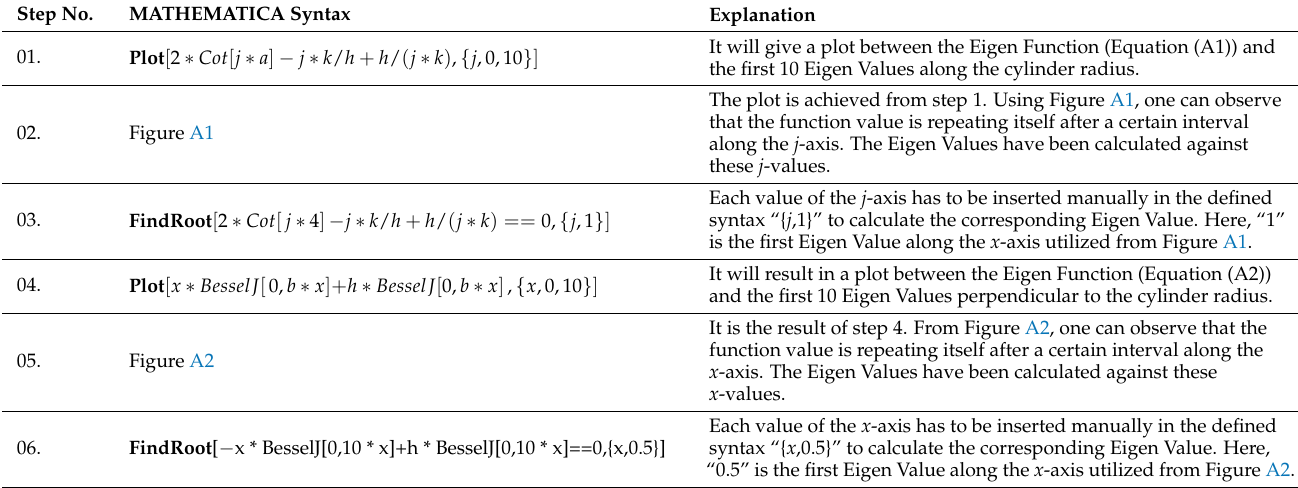
Table A2. User-defined code in “MATHEMATICA” software with illustration utilized to calculate the Eigen Values based on Equations (A1) and